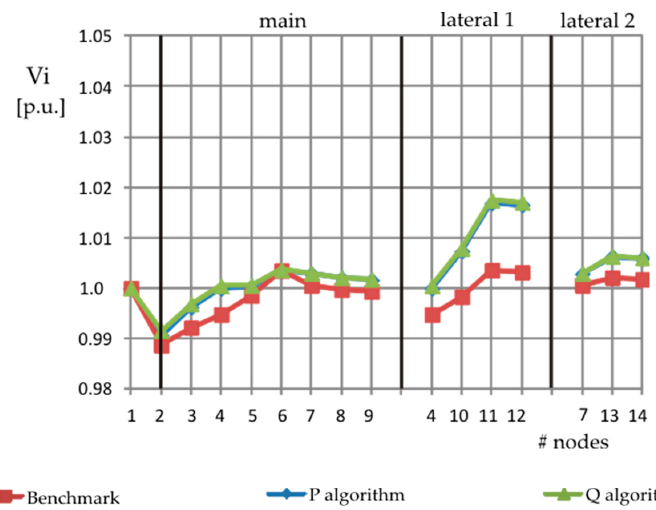
Figure 12. Voltage profiles of the Benchmark and proposed voltage optimization problem (VOP) with four VCZs for Case R ≈ X — DG: feeder 1.